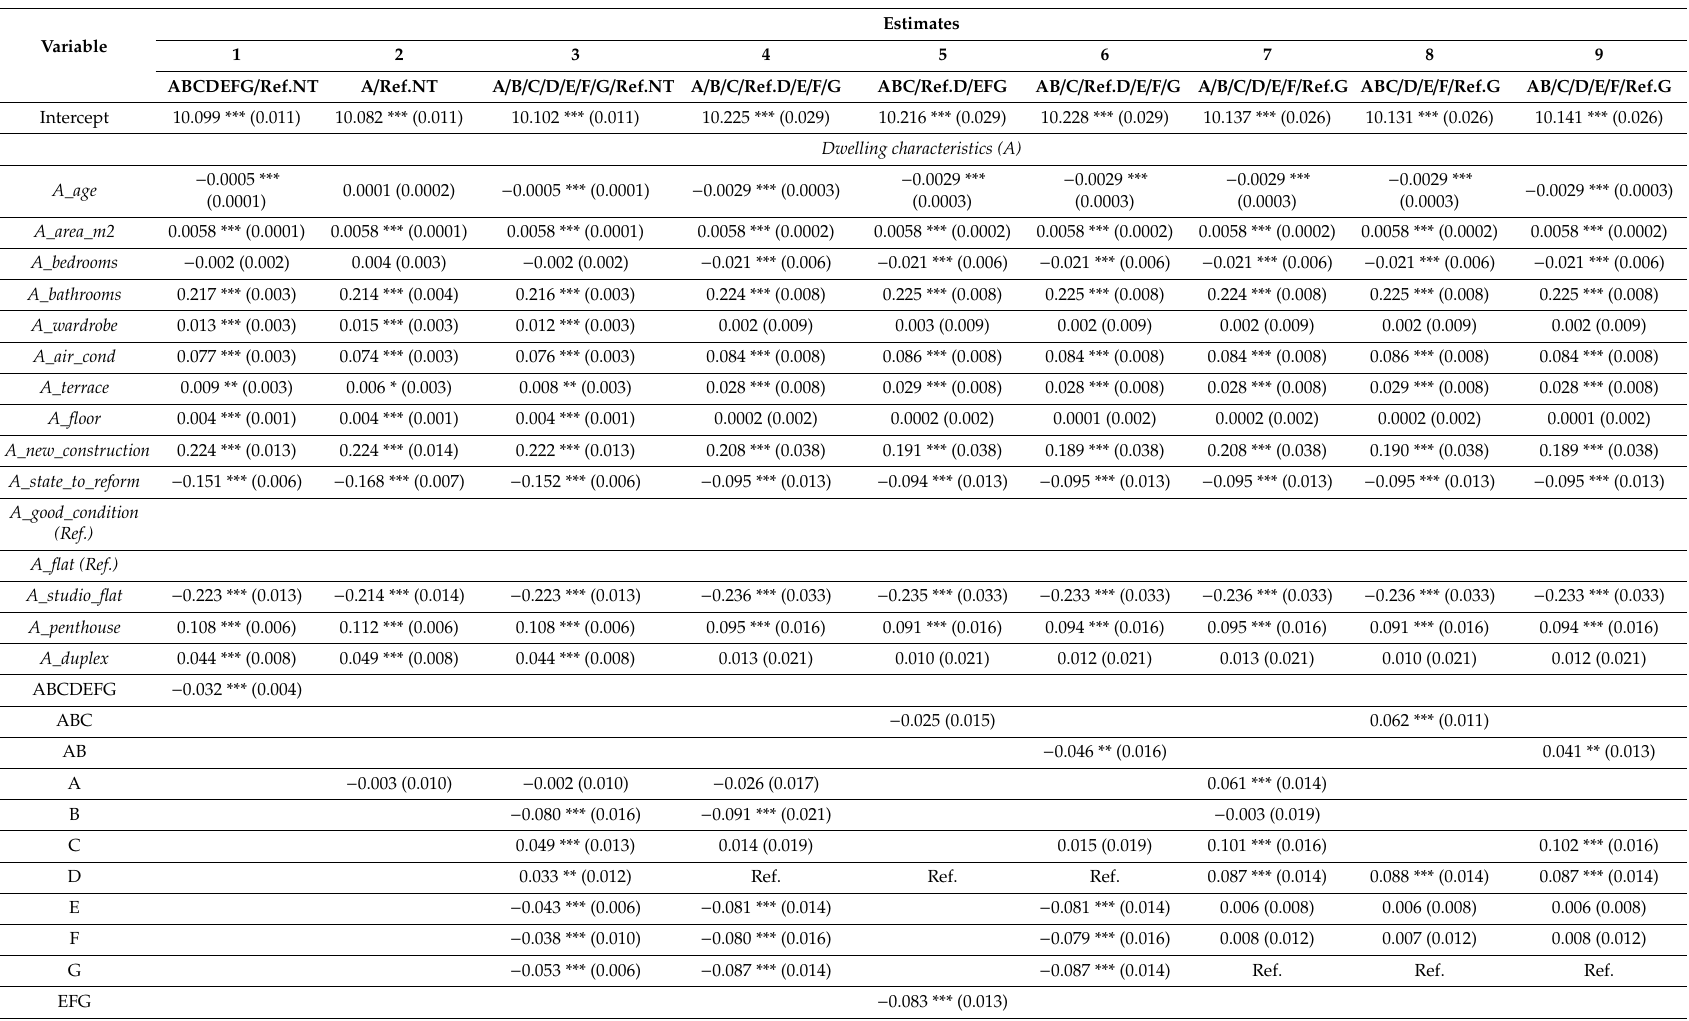
Table 5. Results of the model estimations according to the energy